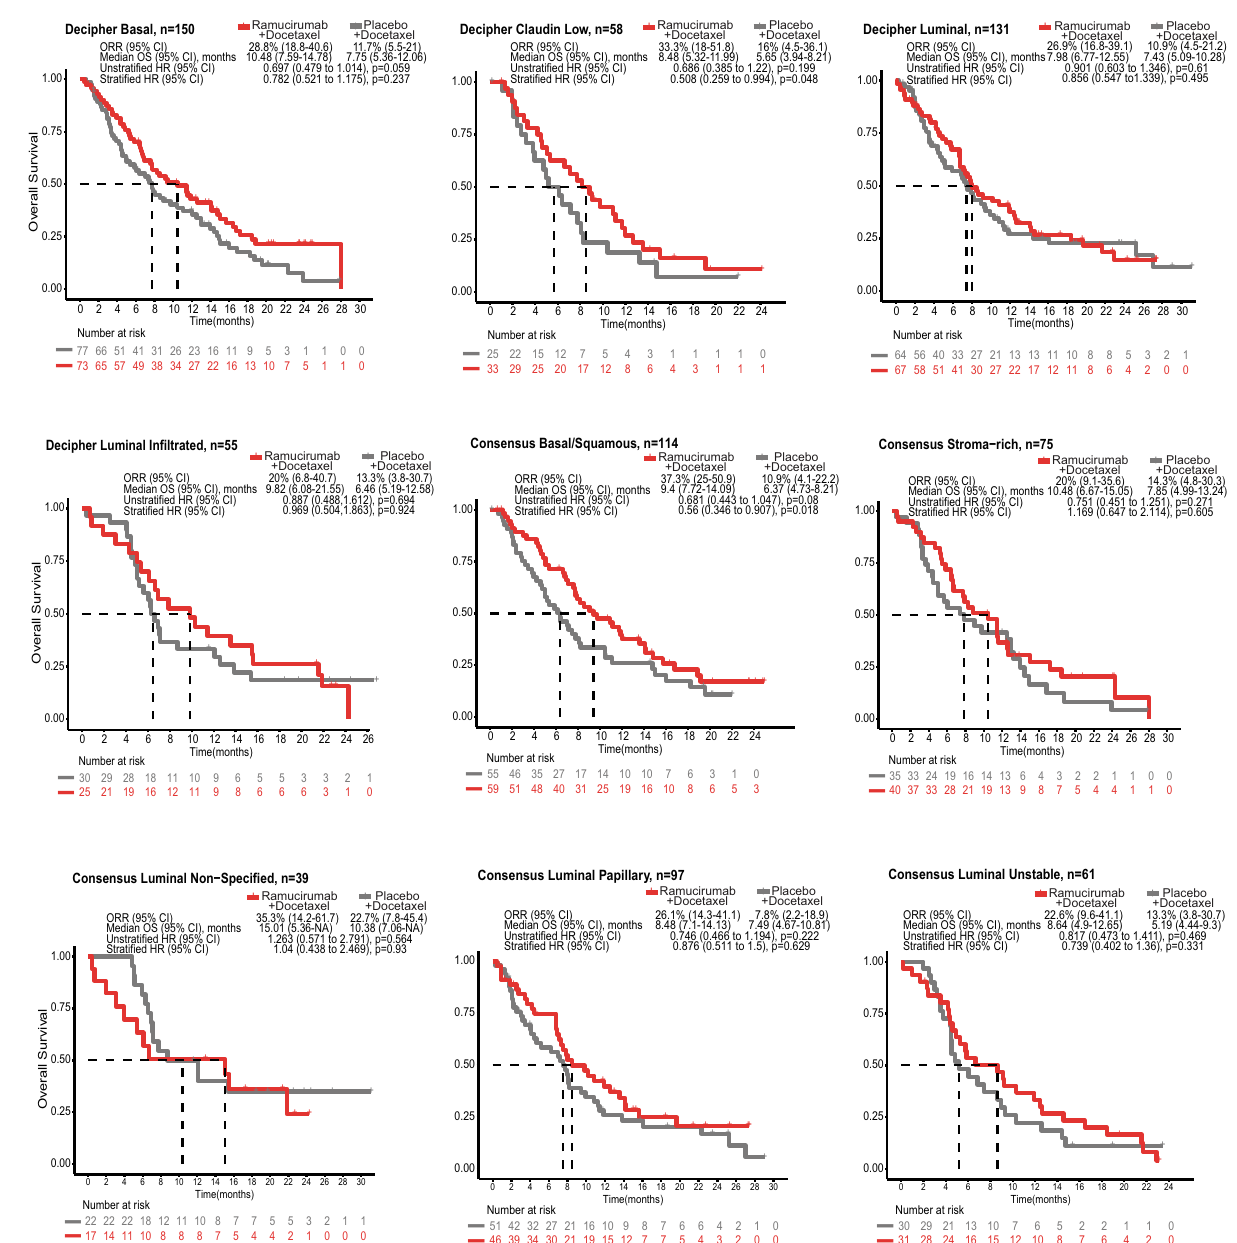
Fig. 4 Molecular subtype association with clinical outcome. Kaplan – Meier curves representing OS probability in ramucirumab + docetaxel or placebo + docetaxel arms based on Decipher GSCv1 molecular subtypes (Basal [ n = 150 participants], Claudin Low [ n = 58 participants], Luminal [ n = 131 participants], and Luminal In fi ltrated [ n = 55 participants]) or ConsensusMIBC (Basal/Squamous [ n = 114 participants], Stroma-rich [ n = 75 participants], Luminal Non-Speci fi ed [ n = 39 participants], Luminal Papillary [ n = 97 participants], and Luminal Unstable [ n = 61 participants]) molecular subtype. Neuroendocrine-like subtype was not analyzed due to low number of patient samples for this subtype ( n = 8). ORR, median OS, and strati fi ed/unstrati fi ed HRs are shown. A two-sided Wald test was used in Cox regression. p -values before BH-adjustment are shown in fi gures. p -values after BH-adjustment are shown in Supplementary Table 1. Strati fi cation was based on geographical region, baseline ECOG PS, and visceral metastases. TR2 population ( n = 394 participants) is used. The proportional hazard assumption was not violated in any instance. Source data are provided as a Source Data fi le. BH, Benjamini- Hochberg; CI, con fi dence interval; ECOG PS, Eastern Cooperative Oncology Group Performance Status; HR, hazard ratio; n, number of participants; ORR, objective response rate; OS, overall survival; TR, translational research. and immune signatures across Basal and Luminal subtypes p = 0.134) (Fig. 4 and Supplementary Table 1). The association (Fig. 3b, c), showed reduced treatment bene fi t compared to the of OS with Basal/Squamous subtype was also consistent when Basal/Squamous subtype. The interaction between treatment and using a TCGA 2017 classi fi cation (Supplementary Fig. 2). The Decipher GSCv1 subtypes (Claudin Low vs. others) was not Luminal Papillary subtype, which had the lowest overall mean signi fi cant ( p = 0.32), while the interaction between treatment signature score for both angiogenesis (excluding n = 8 NE-like) and ConsensusMIBC subtypes (Basal/Squamous vs. others) was NATURE COMMUNICATIONS| (2022) 13:1878